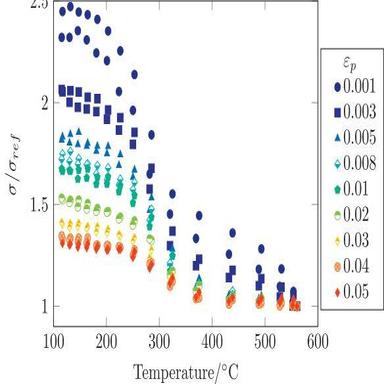
Distribution of the normalised flow stress at different plastic strains, according to the maximum temperature Tpeak of the heat treatment.